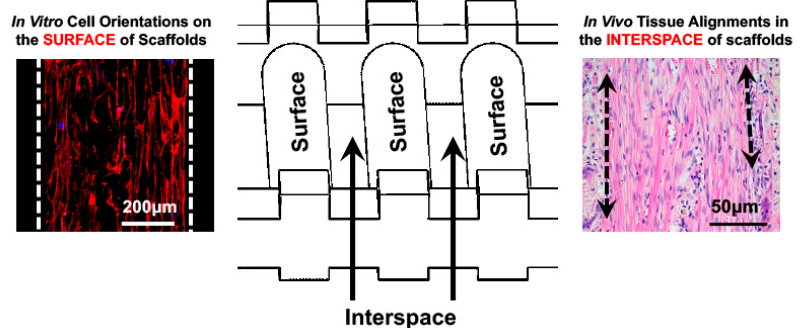
Figure 6. The schematic illustration shows the rat PDL cell orientations on PDL-guiding structure surfaces with angulated microgroove patterns and fibrous tissue alignments in the interface of PDL-guiding architectures.